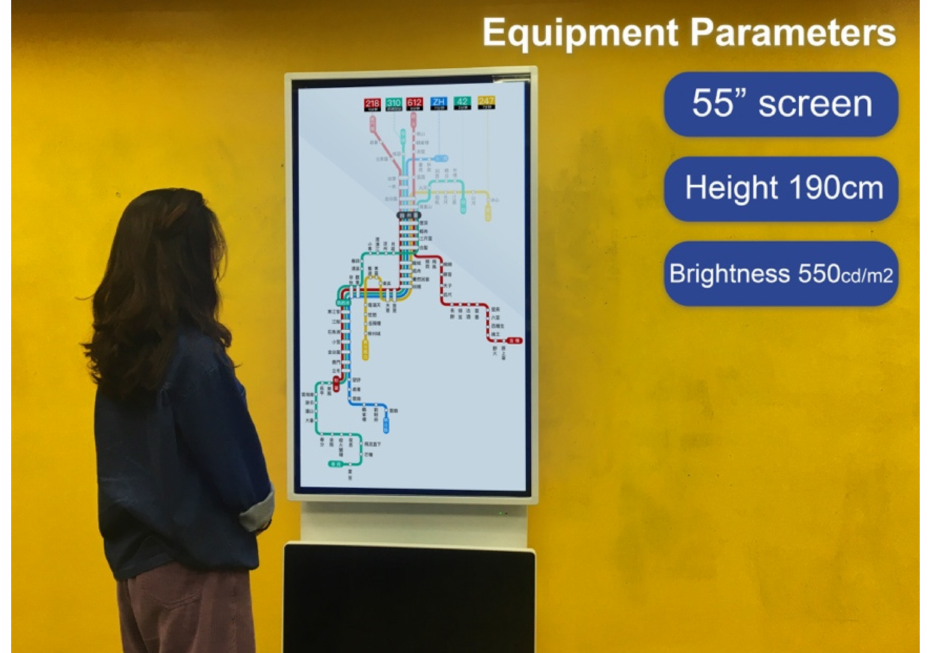
Figure 5. Experimental equipment and